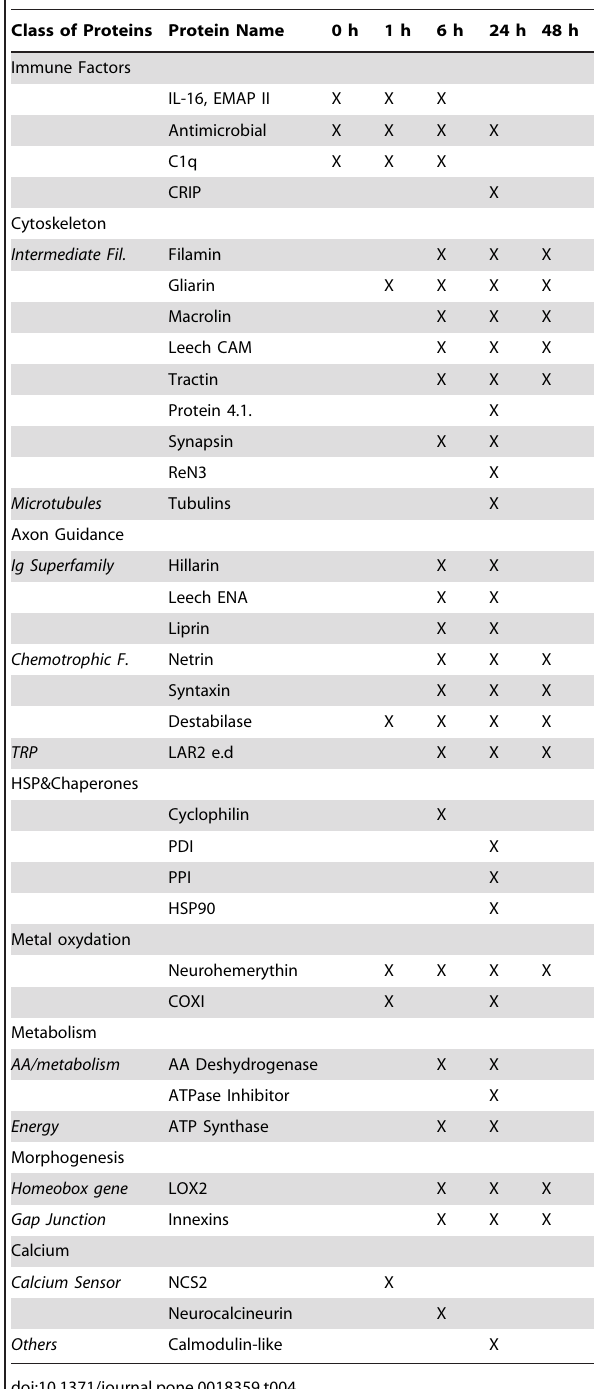
Table 4. Protein identification in time course of regeneration processes based on complementary techniques (2D-Gel [7,9], DD-HPLC, Bottom-up proteomic and soustractive DNA libraries